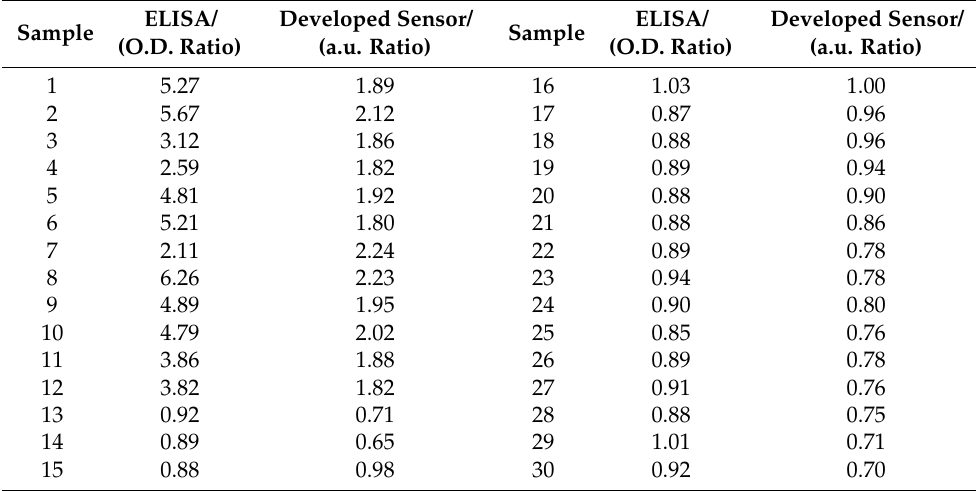
Table 2. Detection results of field samples using the developed biosensor and an